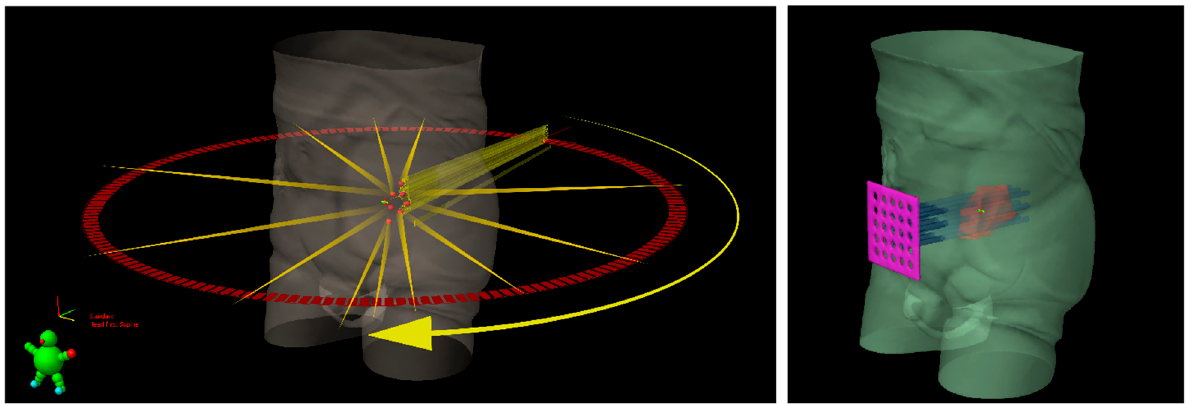
Figure 1. Schematic representation of Lattice radiotherapy with IMRT delivery (on the left ) and GRID radiotherapy with a sieve-like physical filter (on the right ) for a bulky tumoral mass, inside which seven high dose spheres (red vertices) are shown.